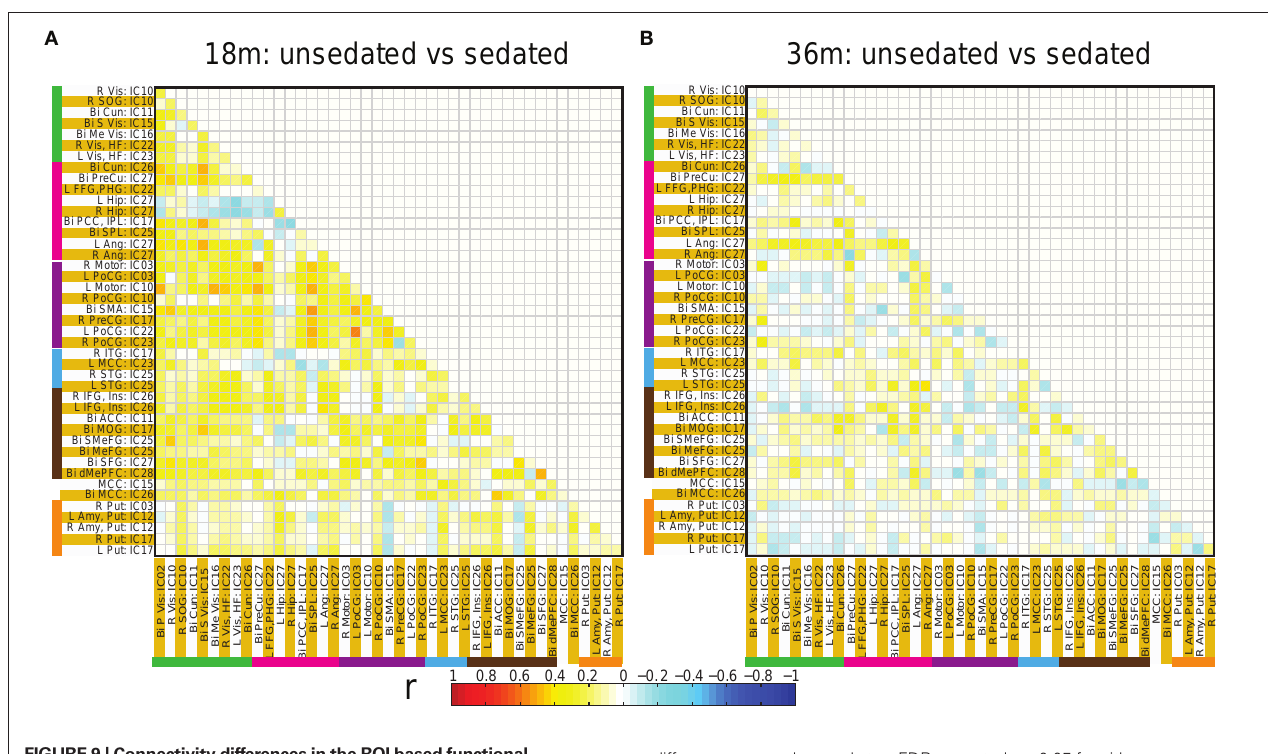
differences were observed at an FDR corrected p < 0.05 for either groups, a trend towards higher connectivity for unsedated children was observed